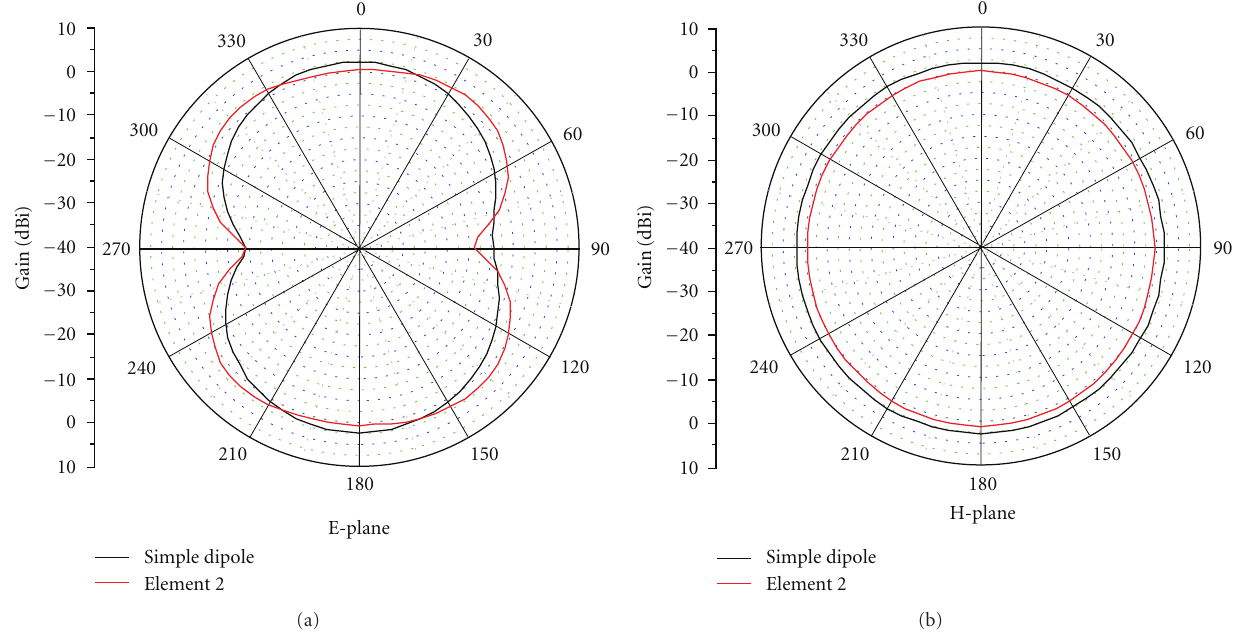
Figure 16: Simulated radiation diagrams of single and element 2 dipoles without reflector plate at 2.44 GHz.